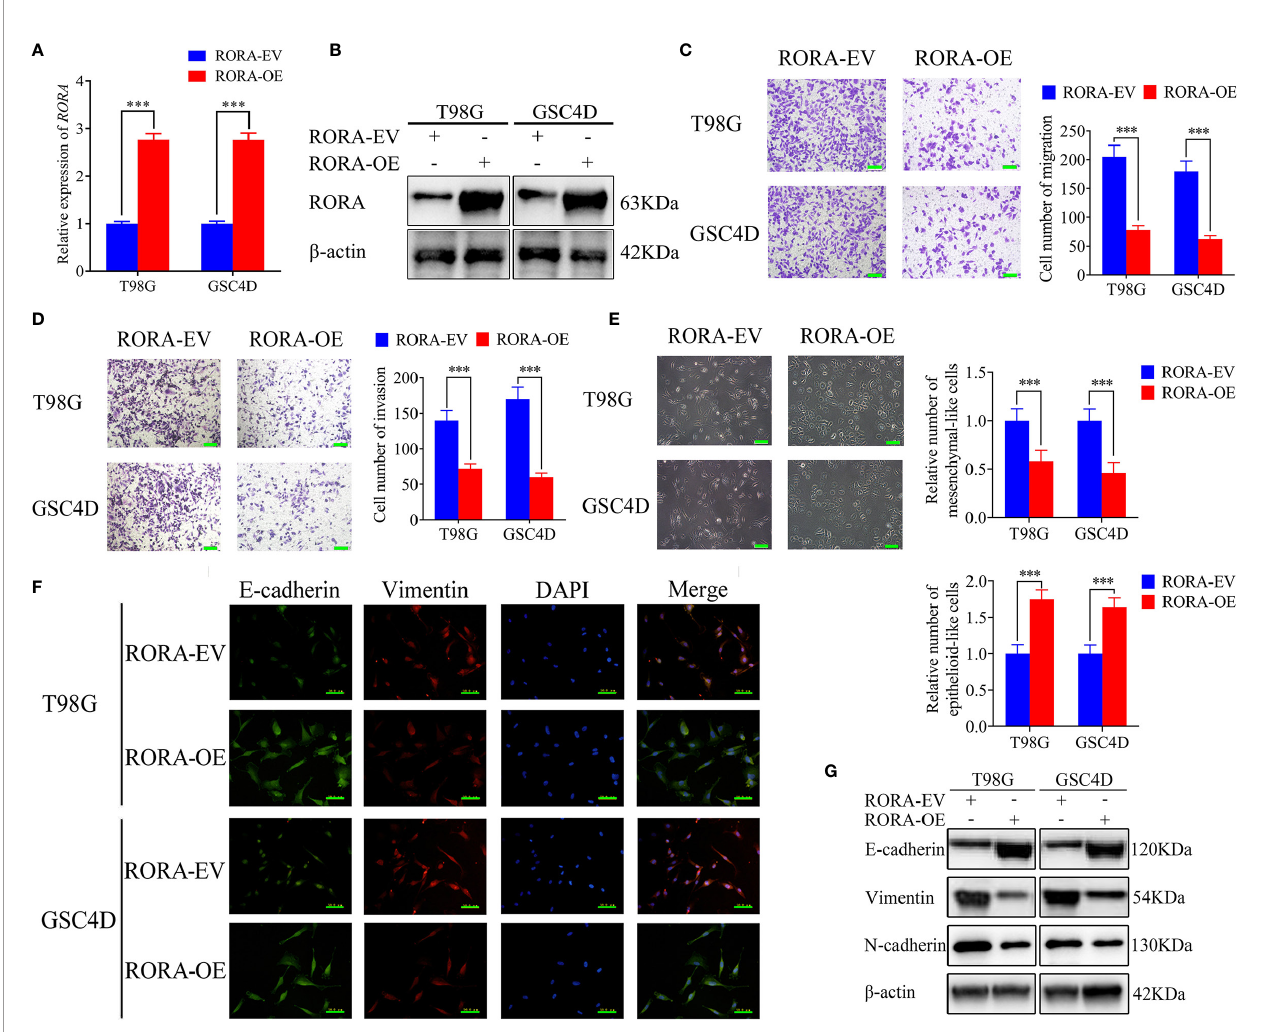
FIGURE 2 | RORA inhibits the migration and invasion of GBM cells in vitro and blocks the epithelial-mesenchymal transition (EMT) in GBM. (A, B) qPCR (A) and western blotting (B) showing the validation of RORA overexpression. (C, D) Representative migration assay and transwell assay showing the migration rates and invasion rates of T98G cells and GSC4D with RORA overexpression, and the negative control. Scale bar = 100 m m. (E) Representative microphotographs showing the morphological changes in RORA-overexpressed T98G cells and GSC4D. Scale bar = 50 m m. (F, G) Representative immuno fl uorescence staining (F) and western blotting (G) showing the changes in E-cadherin, vimentin, and N-cadherin in T98G cells and GSC4D after RORA overexpression. Scale bar = 50 m m. EV, empty vector; OE, overexpression. All data are expressed as the mean ± SD (three independent experiments). ***P <